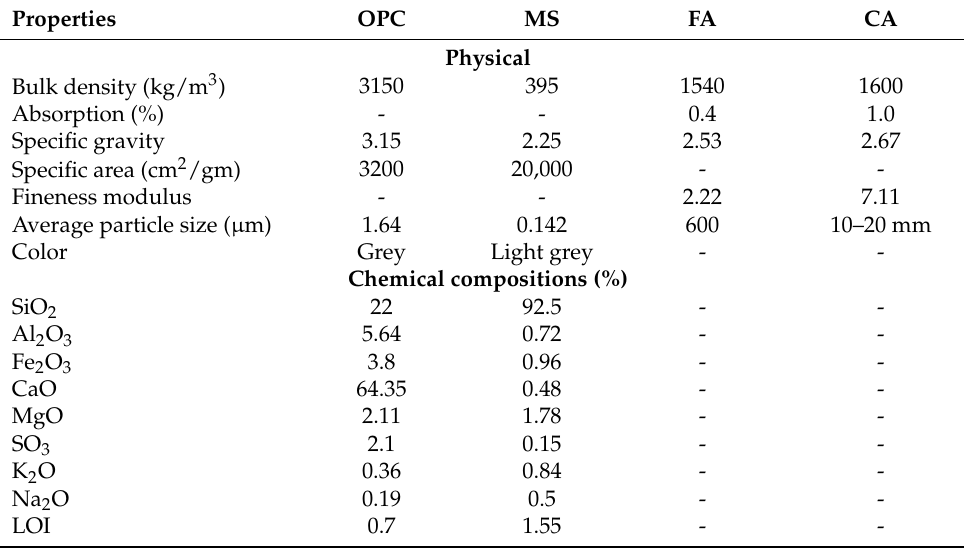
Figure 1. Particle size distribution of fine aggregate. Table 1. Physical properties of OPC, MS, FA, and CA.